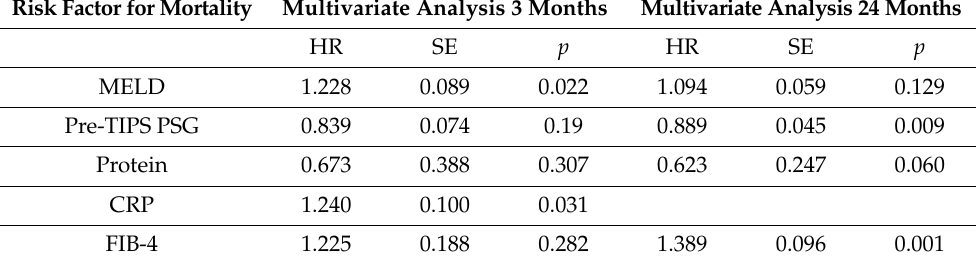
Table 3. Multivariate Cox regression analyzing risk factors for short- and long-term mortality after TIPS insertion. All statistically significant parameters tested in the univariate analysis were included in the multivariate model.